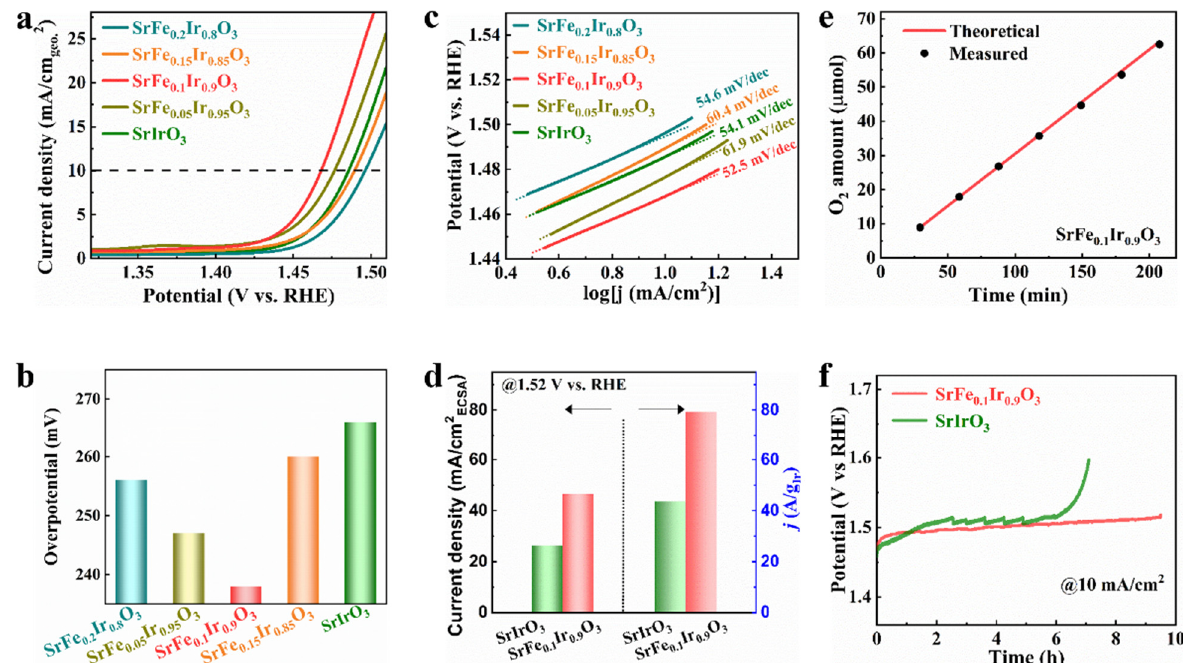
Figure 2. ( a ) Polarization curves of SrIrO 3 and SrFe x Ir 1-x O 3 normalized by geometric area in 0.1 M HClO 4 solution with 85% IR compensations. ( b ) Overpotentials of SrIrO 3 and SrFe x Ir 1-x O 3 at 10 mA cm − 2 in 0.1 M HClO 4 solution. ( c ) The Tafel slope of the samples in ( a ). ( d ) ECSA and iridium amount normalized current density of SrIrO 3 and SrFe 0.1 Ir 0.9 O 3 at 1.52 V. ( e ) The amount of O 2 theoretically calculated and experimentally measured in the presence of SrFe 0.1 Ir 0.9 O 3 versus time at a current density of mA cm − 2 . ( f ) Chronopotentiometric curve of SrFe 0.1 Ir 0.9 O 3 and SrIrO 3 in 0.1 M HClO 4 solution at 10 mA cm − 2 for OER.